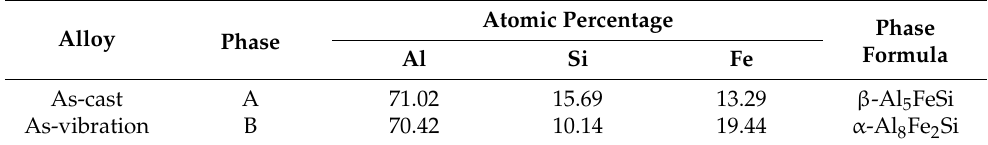
Figure 2. XRD ( a ) and SEM images of as-cast Al-7Si-3Fe alloy ( b ) and as-vibration ( c ). Table 2. EDS results of the different iron-rich phases in Al-7Si-3Fe alloys.